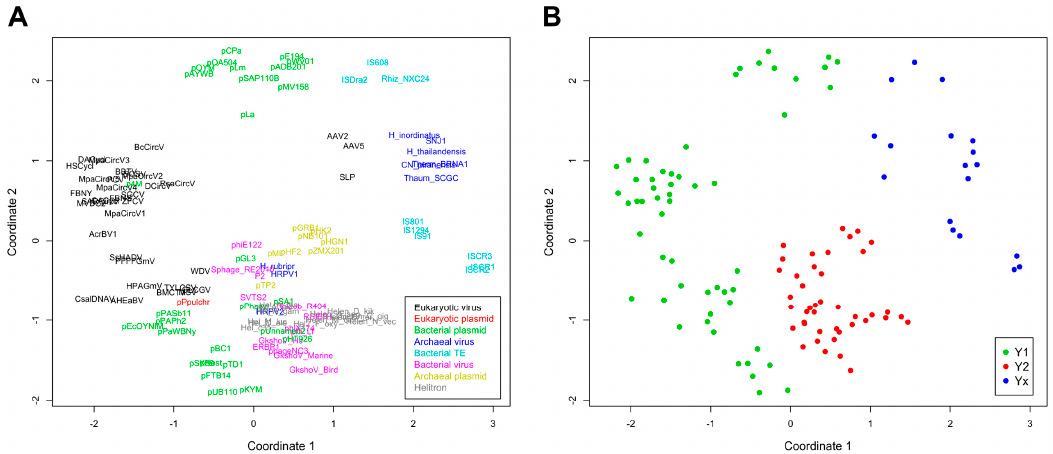
Figure 3. Non-metric multidimensional scaling (NMDS) of evolutionary divergence between RCRE domains. ( A ) Ordinations with taxa represented by their sequence abbreviations. Colors indicate the different classes of mobile genetic elements. ( B ) Same ordinations of ( A ), with colors indicating the tyrosine group of each taxa. The scaling represents euclidean distances for two dimensions (stress: